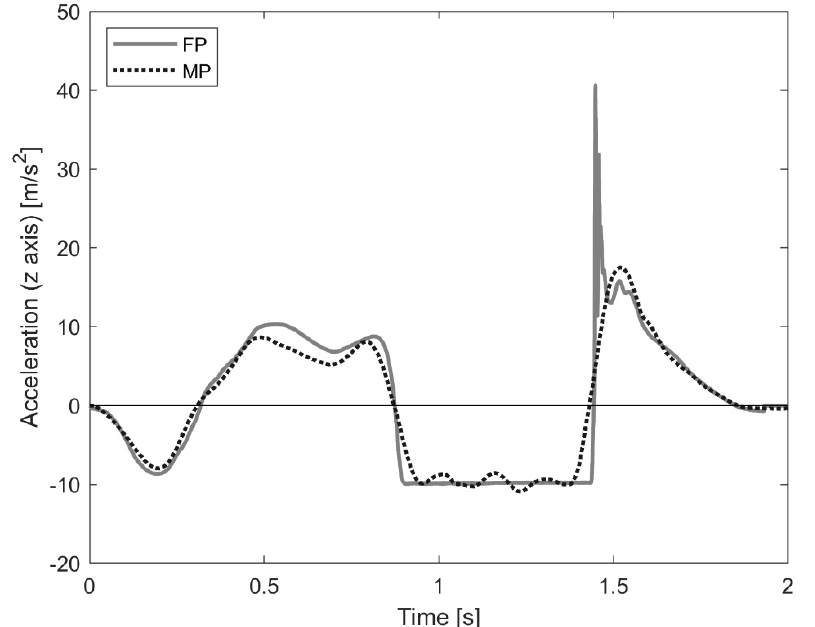
Figure 6. The vertical acceleration time, measured using the MP and determined from the vertical reaction force measured by FP.